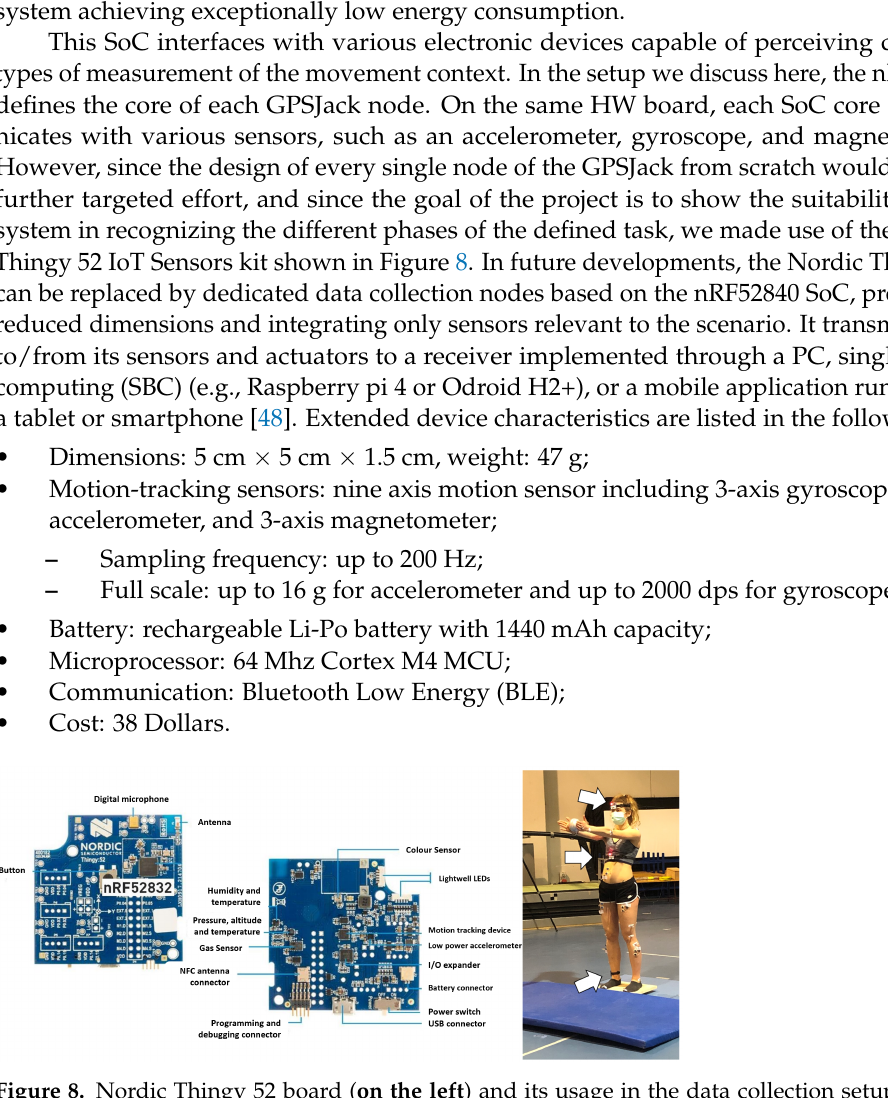
Figure 8. Nordic Thingy 52 board ( on the left ) and its usage in the data collection setup ( on the right